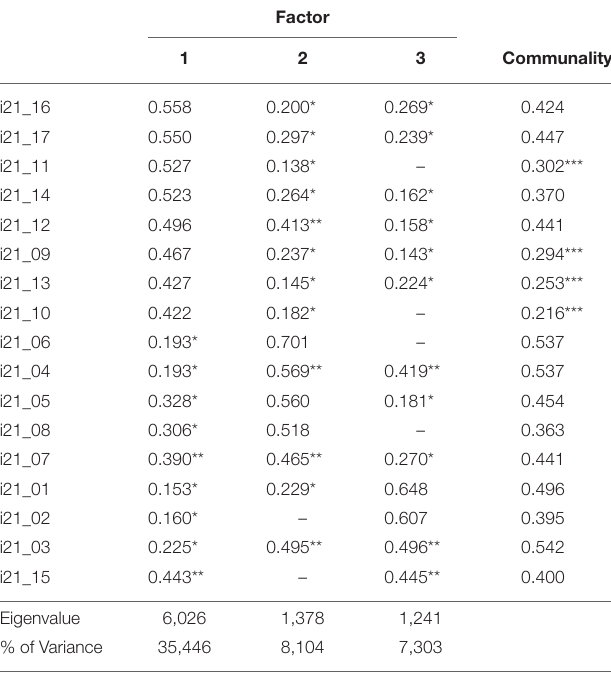
TABLE 2 | EFA of forms of teacher